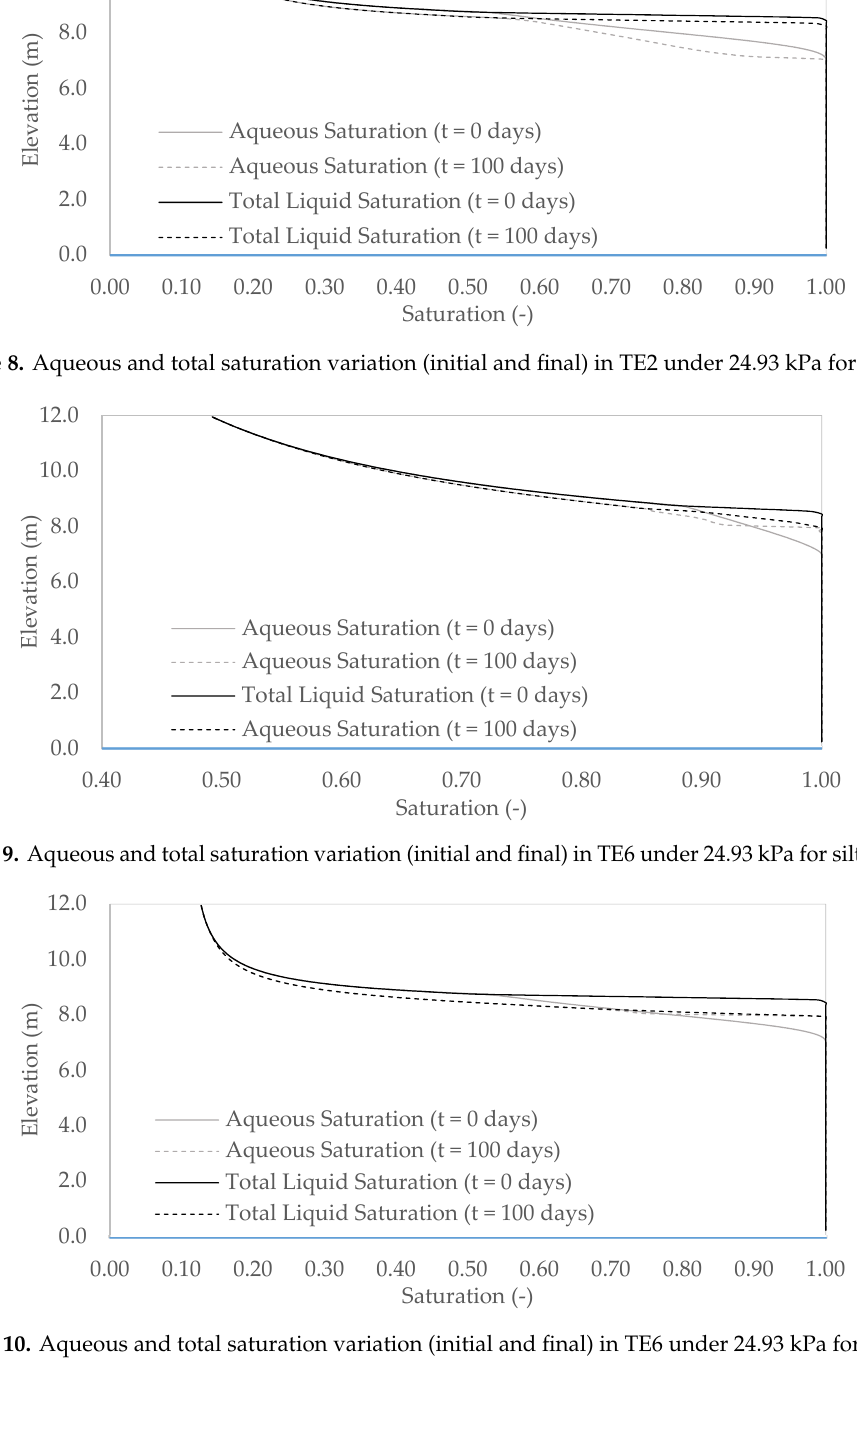
Figure 10. Aqueous and total saturation variation (initial and final) in TE6 under 24.93 kPa for